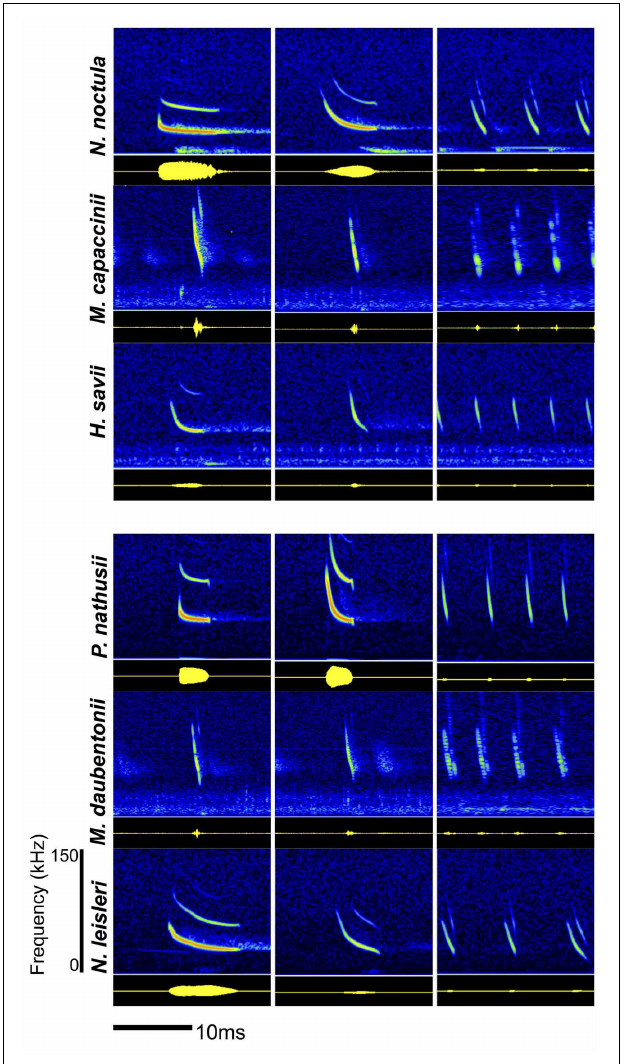
FIGURE 1 | Spectograms (top panel, amplitude color coded) and oscillograms (below, yellow on black) of the echolocation calls of all six recorded bat species. The echolocation calls show species-specific differences and a characteristic change over the course of a feeding event (search phase, approach phase, feeding